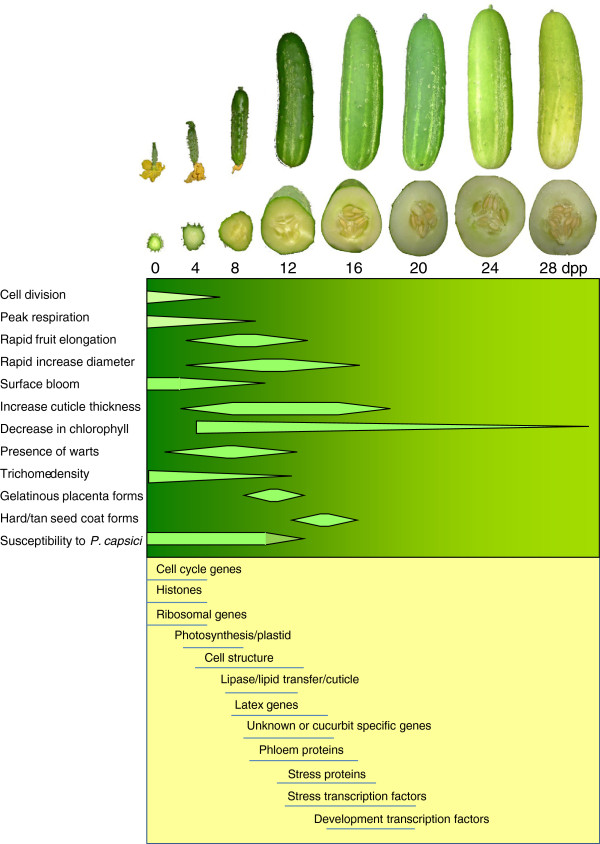
Schematic representation of morphological and gene expression changes occurring during early cucumber fruit development. Gene expression data refer to periods of peak expression for indicated gene categories. Data for respiration, cell division, and susceptibility to P. capsici are from Marcelis and Hofman-Eijer [4], Colle et al. [7], and Gevens et al. [9], respectively